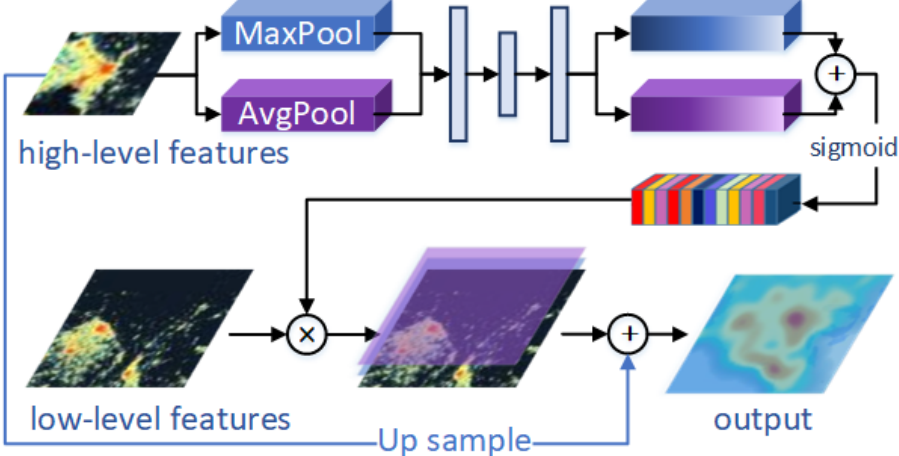
Figure 3. Fusion process of features with different resolution in